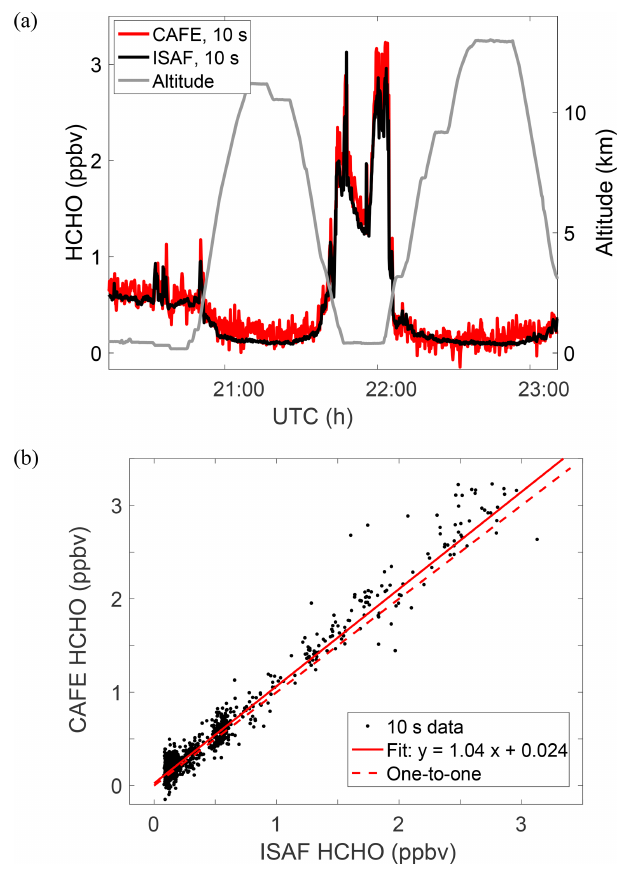
Figure 9. (a) Time series data from TF01 of ATom-3 show good agreement between CAFE (red) and ISAF (black). (b) A linear re- gression (York et al., 2004) of the data yields a slope of 1 . 04 ± 0 . 02 and intercept of 0 . 024 ± 0 . 007. Data from both instruments were averaged to